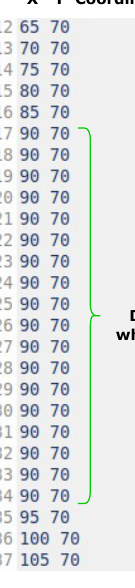
Figure 16. Car1: node1.dat file